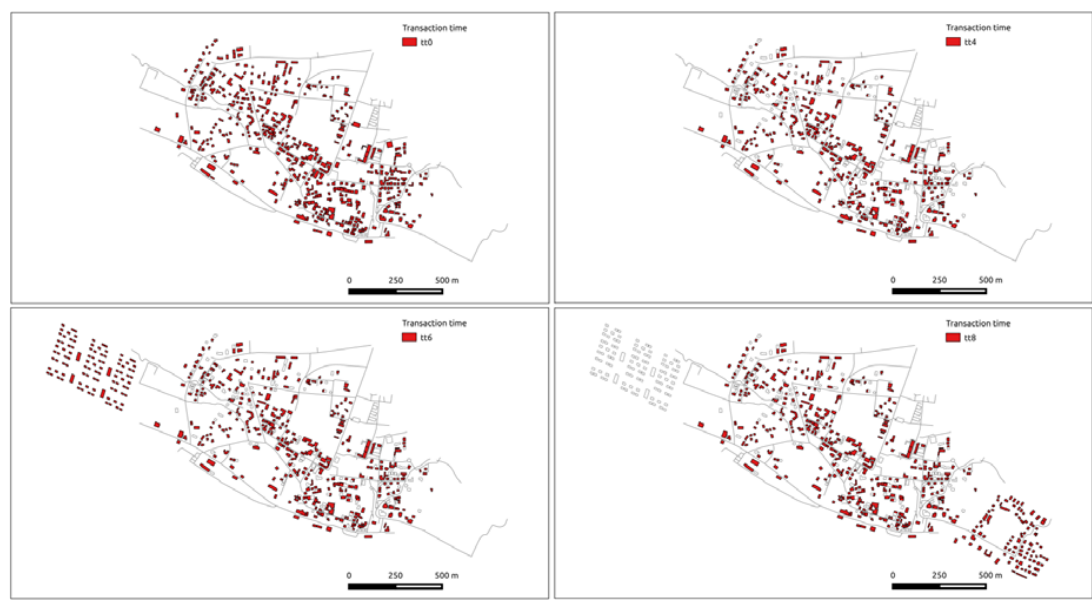
Figure 8. Integrated building inventory at different transaction times as recovered from the database archive by the ttime_gethistory() function.